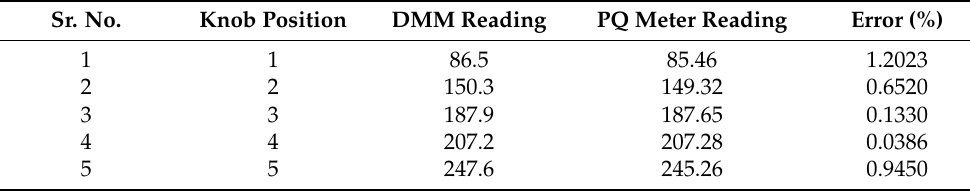
Figure 13. Hardware setup to test true RMS measurement capability. Table 2. RMS measurement of the smart PQ meter.